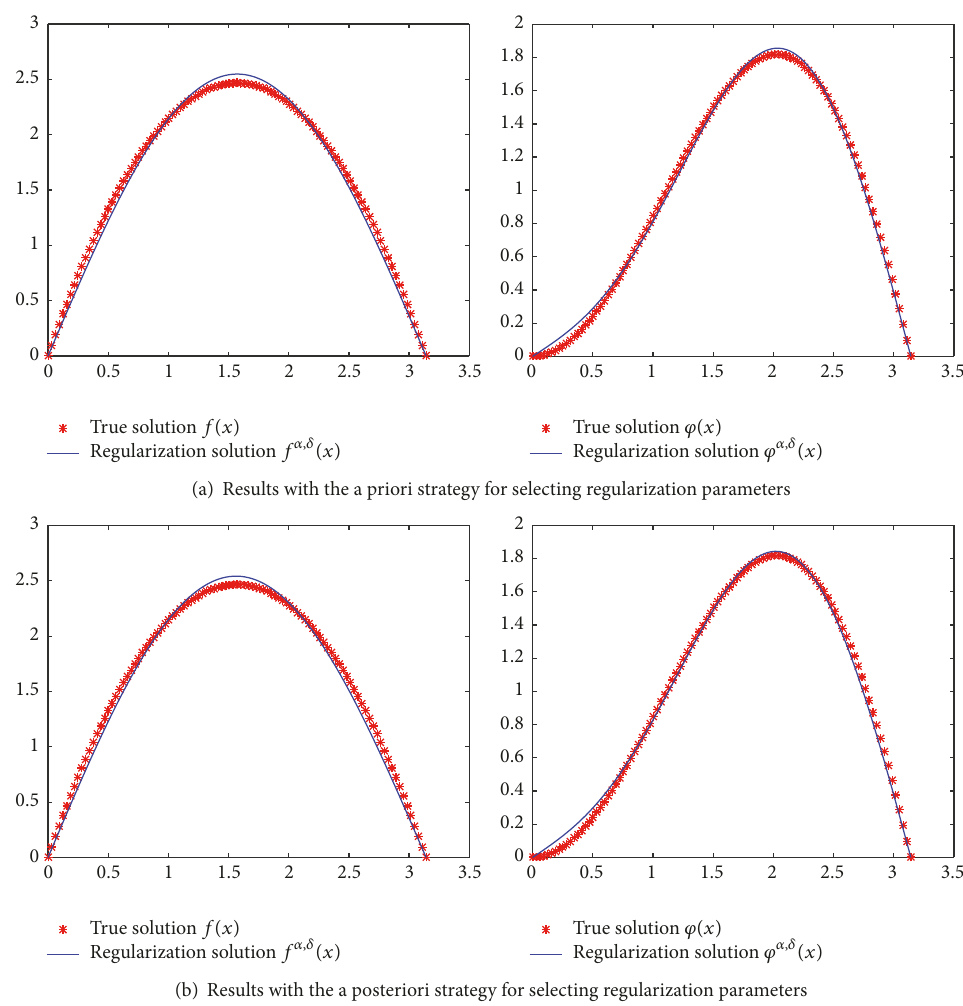
Figure 3: Behaviors of the true and the regularization solution when 𝜌 = 0.05 .